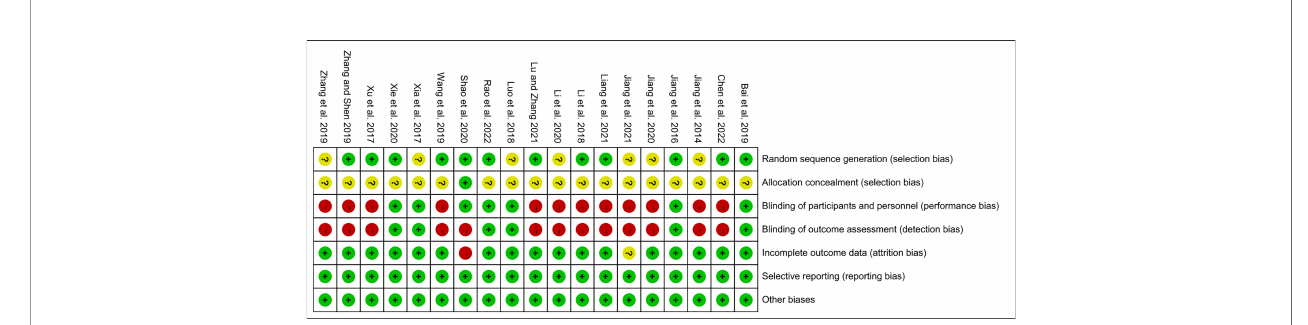
FIGURE 3 | Risk of bias summary.